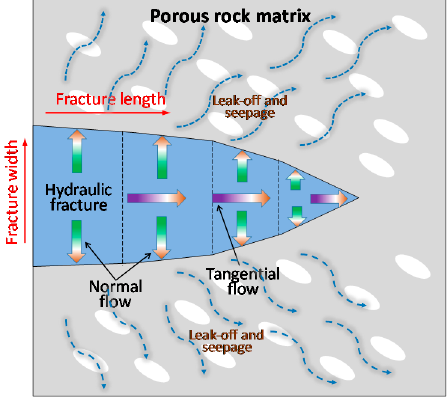
Figure 4. Schematic of fluid flow patterns, including tangential flow and normal flow.